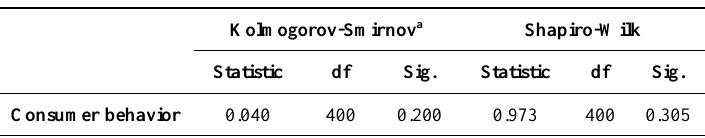
Table 3. Test of